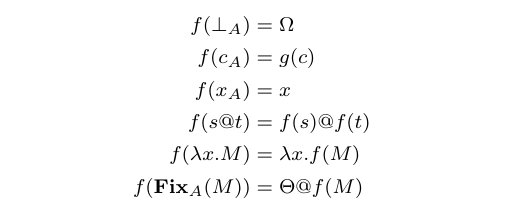
Fig. 1. Translation from PCF to